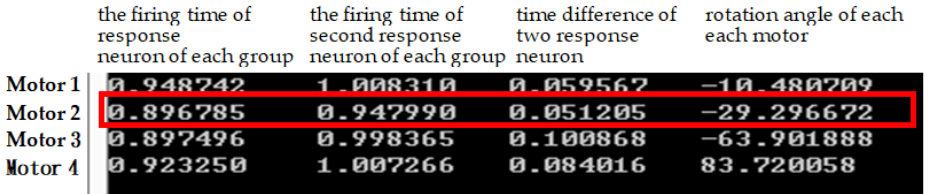
Figure 5. An example of the first response neurons of each group that determine the on/off time of each motor.